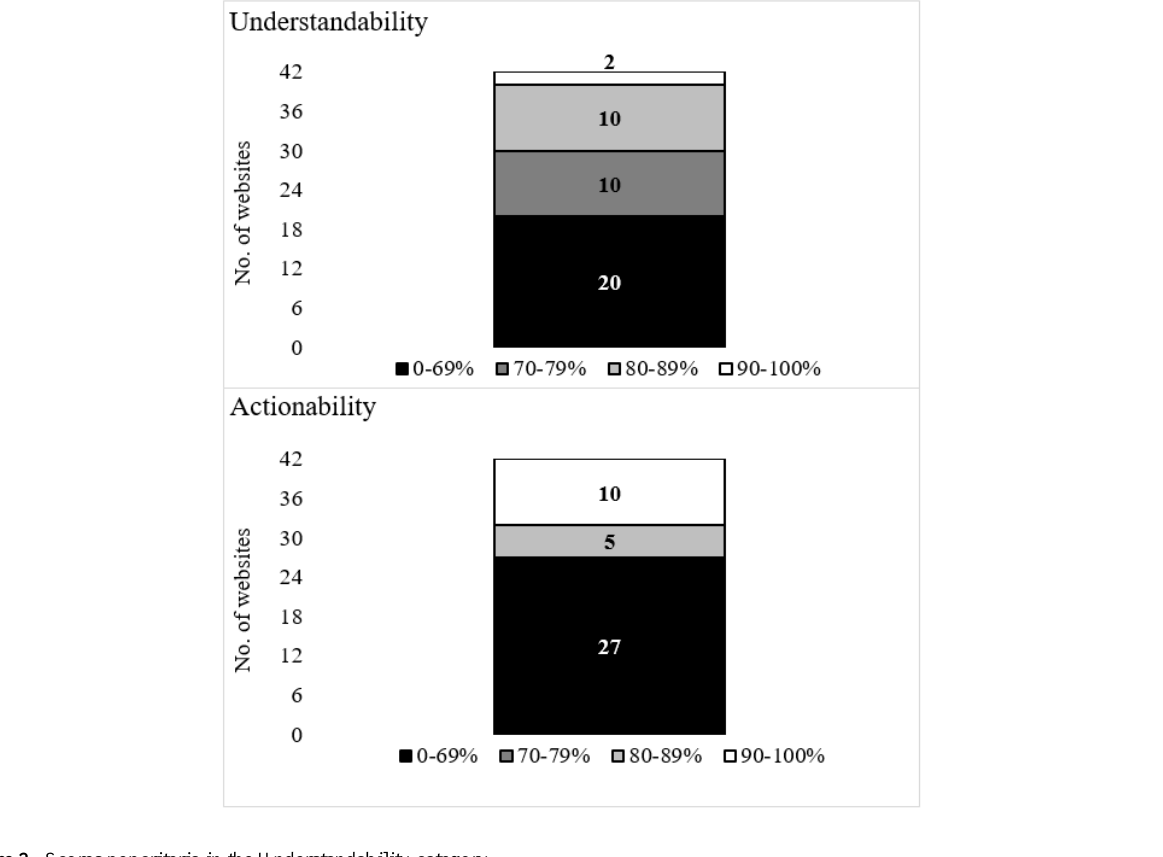
Figure 2. Scores per criteria in the Understandability